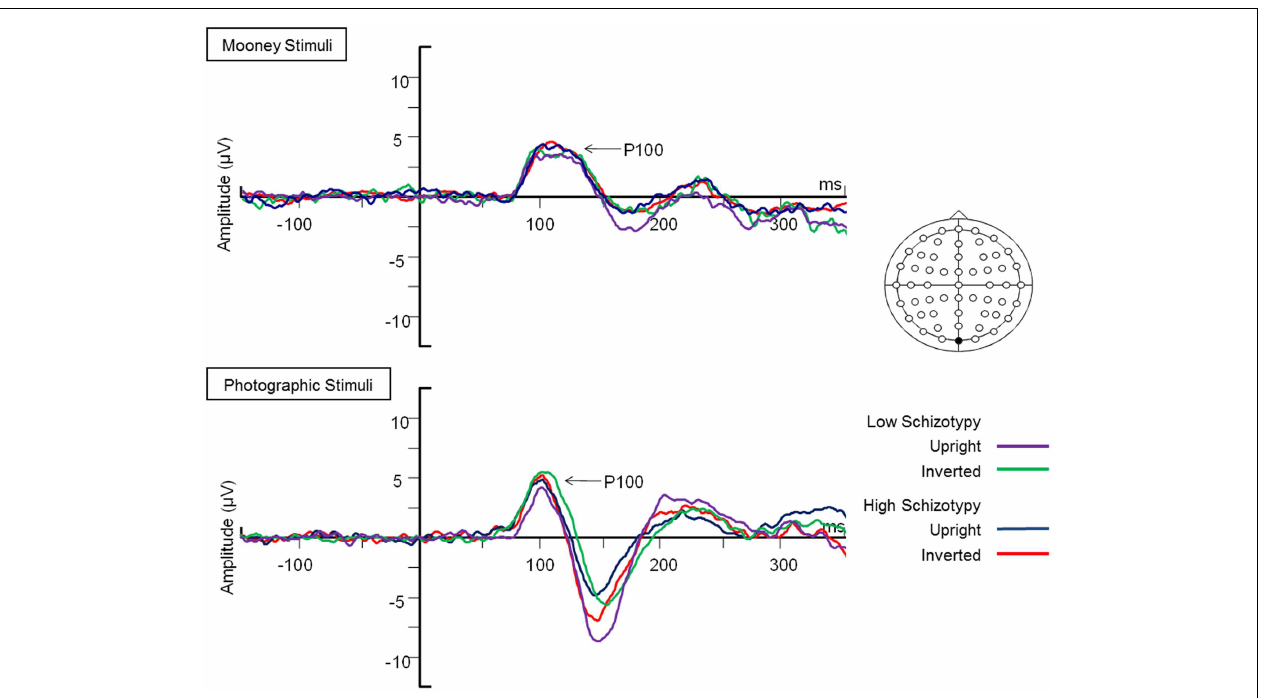
FIGURE 1 | Grand-averaged P100 waveforms at electrode OZ . Upright and inverted stimuli presentations across groups are compared for both tasks. A bird’s eye view of the electrode montage is shown with the plotted electrode shaded black. Negative polarity is plotted downward.